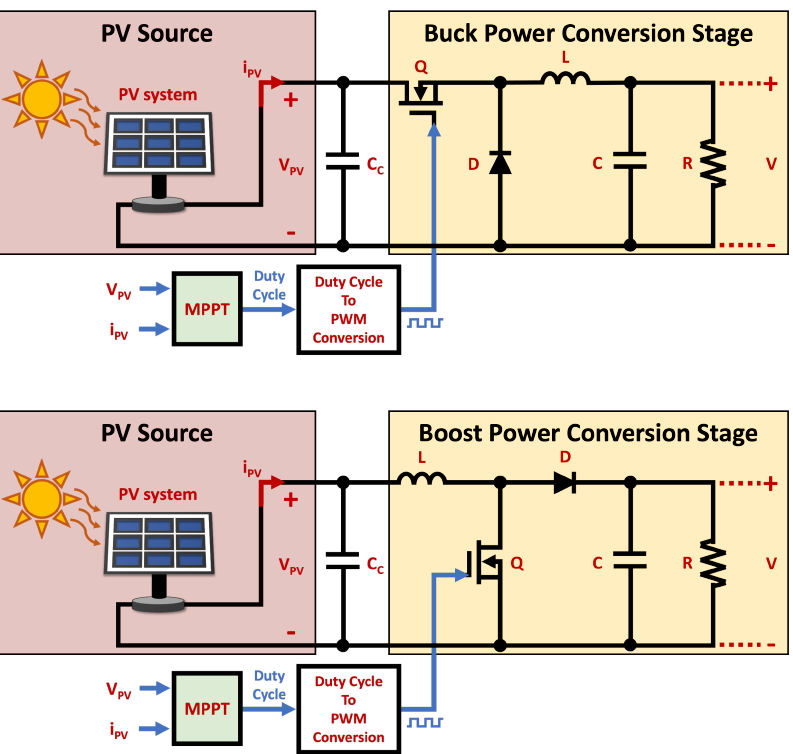
Figure 7. Basic DC–DC converter designs for PV